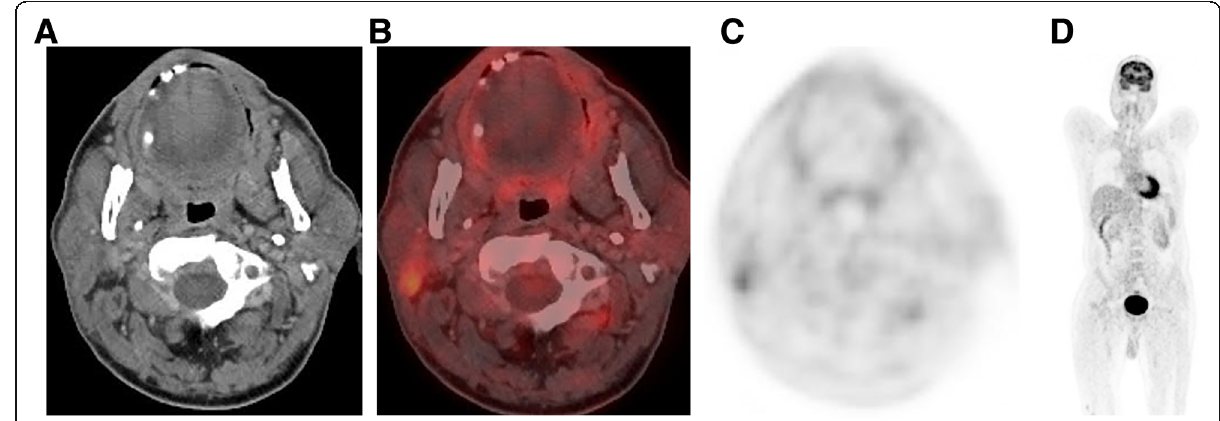
Fig. 3 A 64-year-old male patient presented with pathologically proven metastatic adenocarcinoma right cervical nodes. PET/CT revealed axial CT ( a ), fused PET/CT ( b ), PET ( c ), and MIP ( d ) images showing metabolically active multiple right cervical lymph nodes (SUVmax 5). No other metabolically active lesions detected all over the rest of the body to account for primary malignancy site could be detected